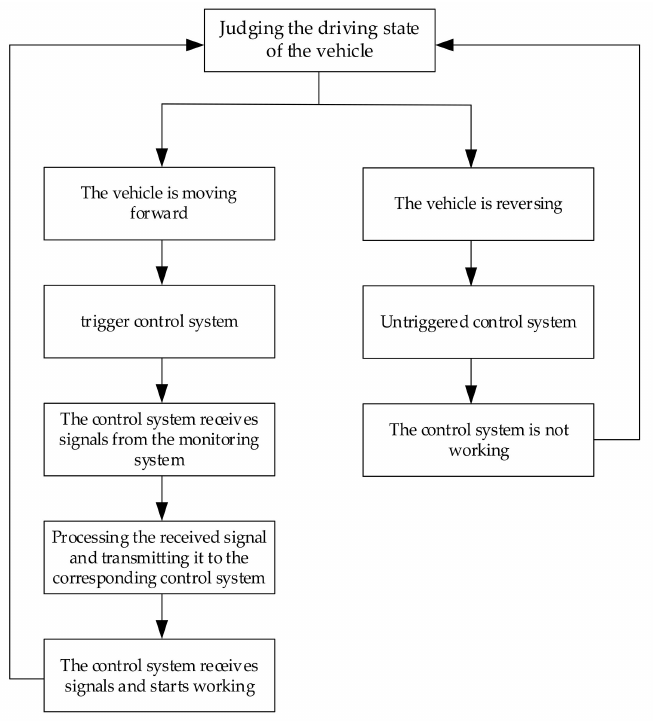
Figure 13. Monitoring and control system